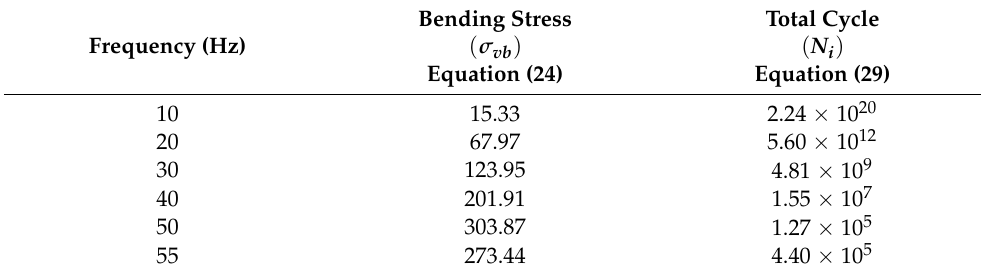
Table 6. Total cycles.